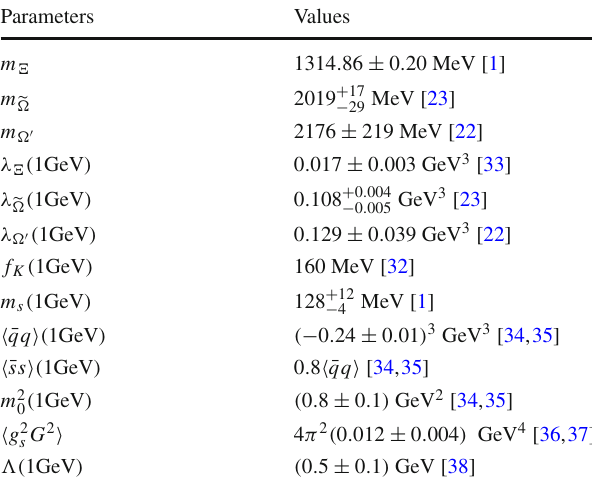
Table 1 Some input